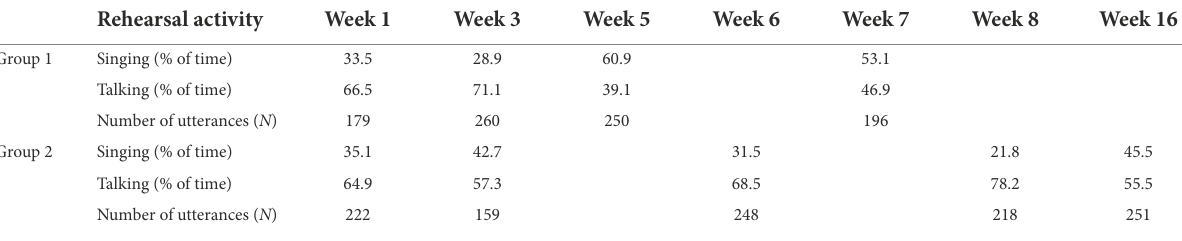
TABLE 2 Singing, talking and number of utterances in sampled period (Groups 1 and